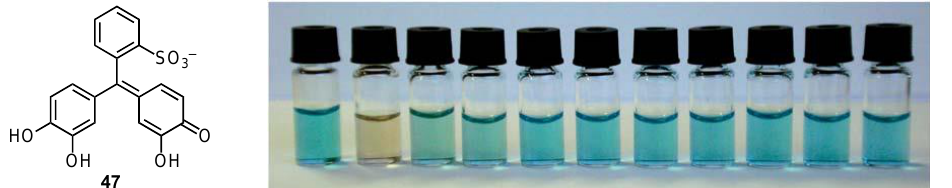
Figure 18. Structure of indicator 47 and picture of solutions containing equimolar mixtures of 46a and 47 (20 μM in 5 mM HEPES buffer at pH 7.4 containing 145 mM NaCl). The vial on the left-hand side contains no additional salt while the other vials contain the sodium salts of PPi, ATP, ADP, AMP, cAMP, phosphothreonine, phosphoserine, phosphotyrosine, HPO 42 − , and citrate (5 equiv each) (from left to right). The picture is reprinted from Ref. [170] with permission from the Royal Society of Chemistry.